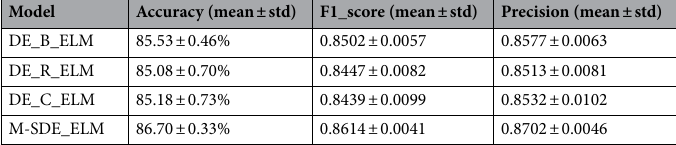
Table 9. Performance comparison between single-strategy and multi-strategy of